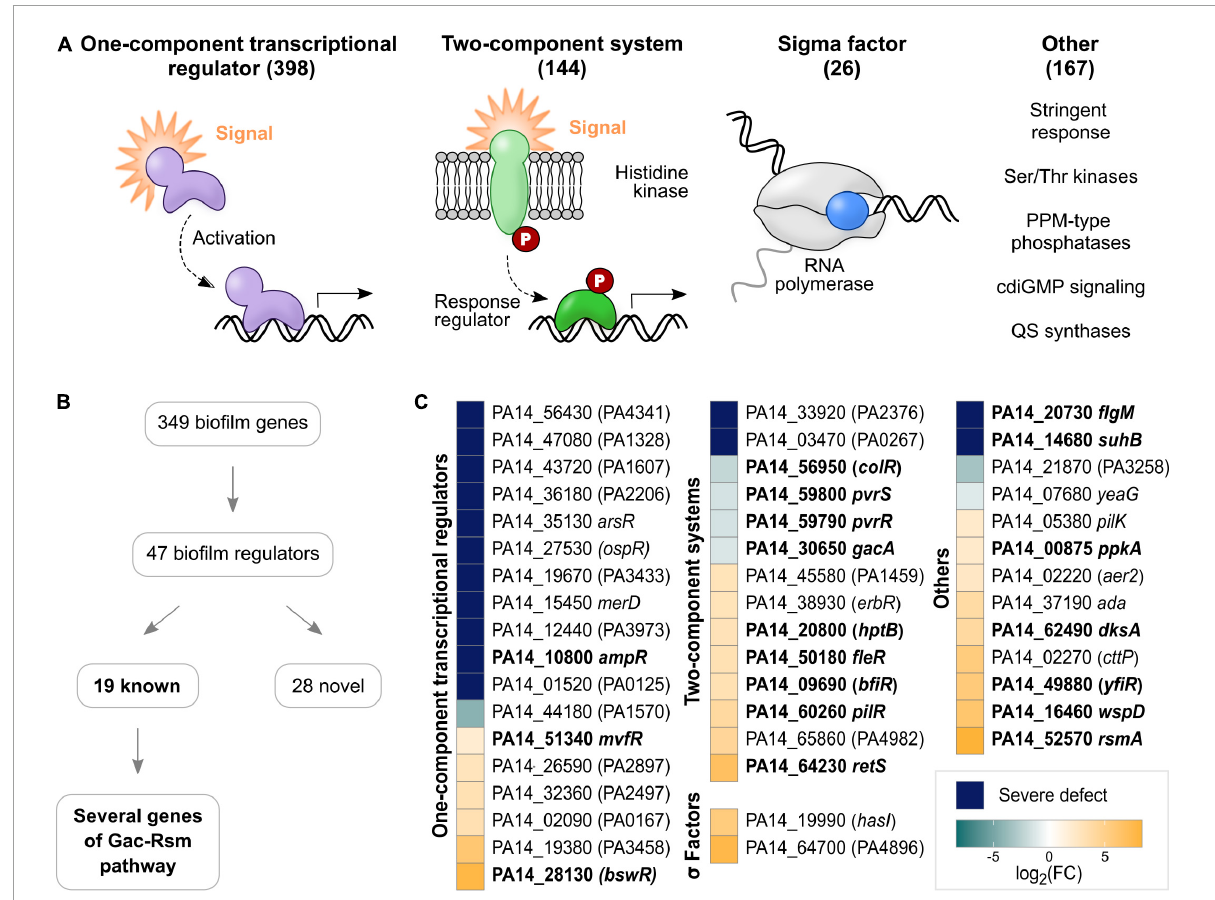
FIGURE2 Regulators involved in biofilm growth of P. aeruginosa PA14 on HA identified with TnSeq. (A) Regulatory genes encoded in the genome of P. aeruginosa PA14 were grouped into OCRs, TCSs, sigma factors and ‘others’. Indicated in brackets are the numbers of genes belonging to each group. Genes previously implicated in biofilm growth are printed in bold, while novel genes are shown in plain font. (B) Flow chart summarizing the main results of the TnSeq screen regarding regulatory genes. (C) The heatmap shows biofilm regulators detected with TnSeq grouped into OCRs, TCSs, sigma factors and ‘others’. Colors illustrate the effect of transposon insertion on fitness in biofilms: dark blue – severe defect; aqua to light blue – decreased fitness; and light orange to yellow – increased fitness). For illustration purposes, fold changes are depicted as a logarithm to the base of